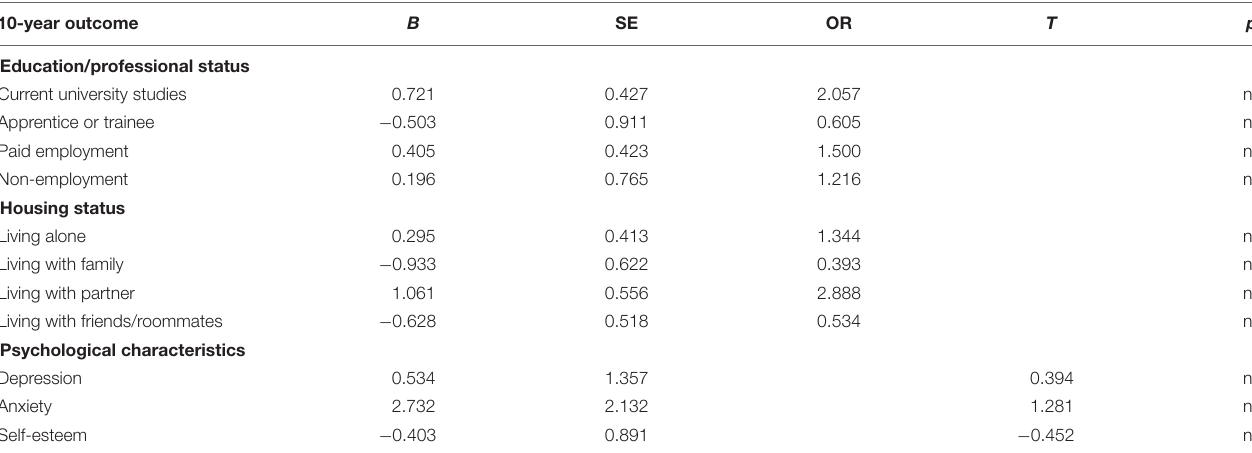
FIGURE 1 | Academic difficulty or success in adolescence as a predictor of selected 10-year socio-professional and psychological outcomes. ∗∗ p < 0.01 and ∗∗∗ p < 0.001. TABLE 3 | Baseline education priority school (versus standard school) as a predictor of 10-year outcomes ( n =